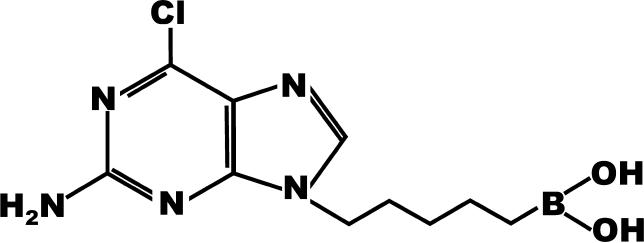
Structure of LMP-420 (2-NH2-6-Cl-9-[(5-Dihydroxyboryl)-Pentyl] Purine)